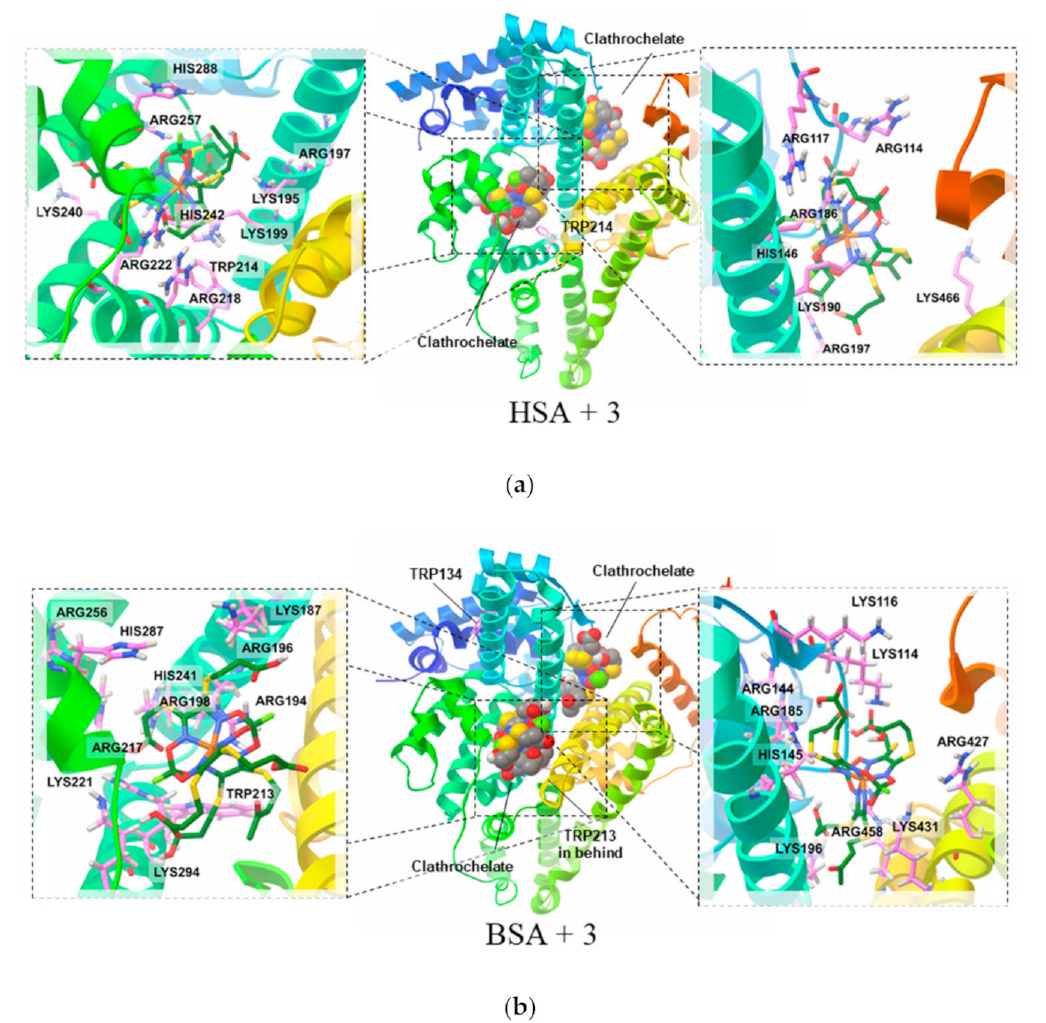
Figure 6. The calculated molecular models of the clathrochelate 3 —HSA [human serum albumin; ( a ) and clathrochelate 3 —BSA (bovine serum albumin; ( b ) guest—host assemblies: their general views (central pictures) and the zoomed views of 3 included in Site I (left side) and in an “additional site” (right side) of these macromolecules. The easily available amino acid residues with charged sidechains and the Trp213 / Trp214 residues of their Site I are also